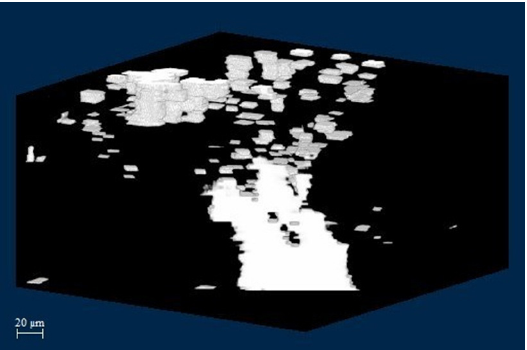
Figure 7. Three-dimensional reconstruction for geometric quantification of porosities, tortuosity and connectivity of EAF dust self-reducing pellet.